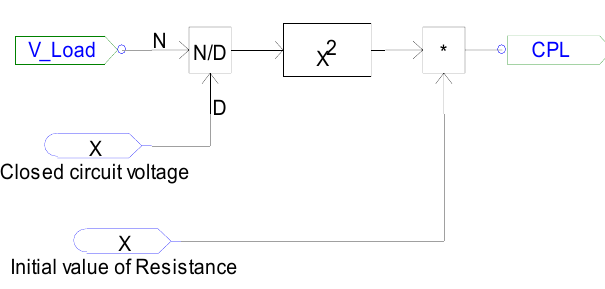
Figure 10. Circuit model for CPL.